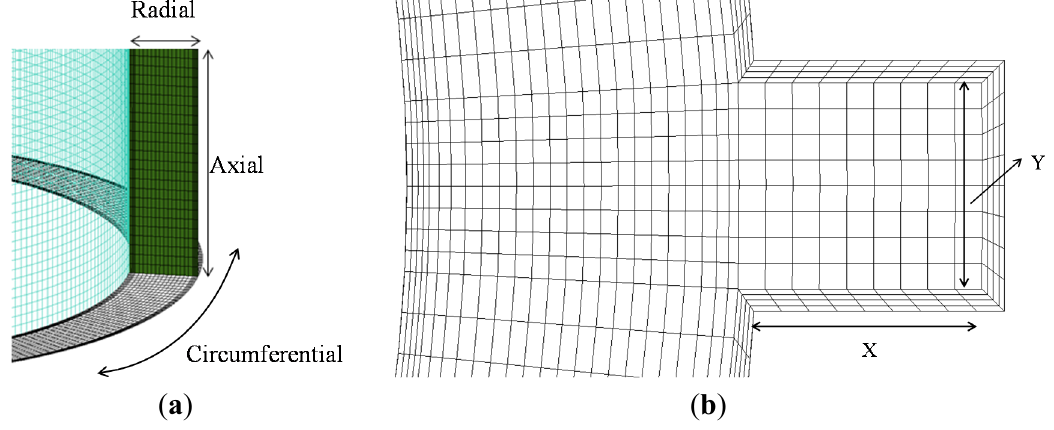
Figure 5. Brief scheme of the mesh construction; ( a ) Plain model; and ( b ) Slit wall